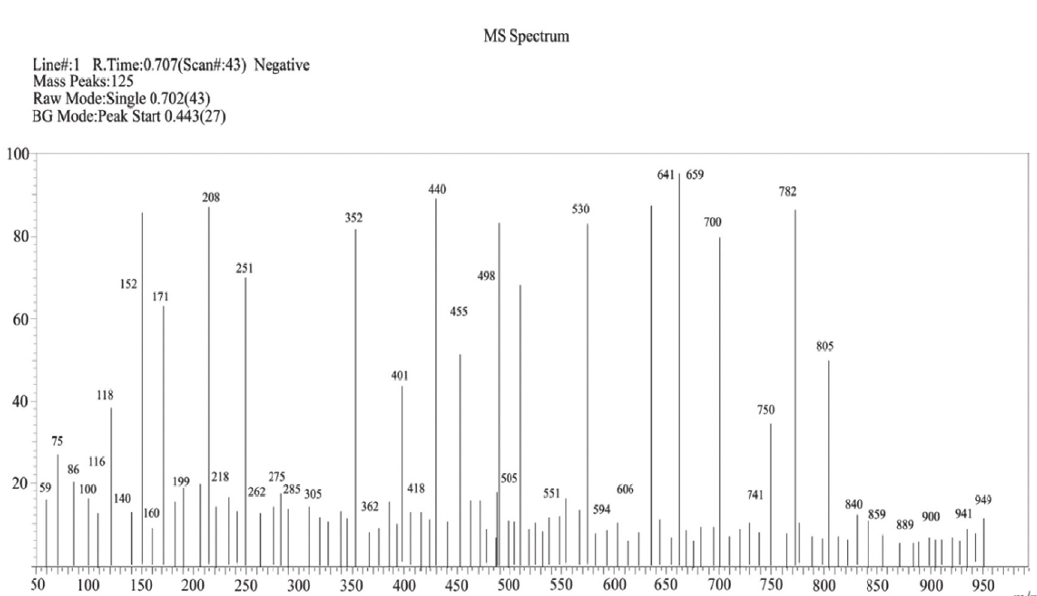
FIGURE 6 - LCMS analysis Rauvolfia serpentina